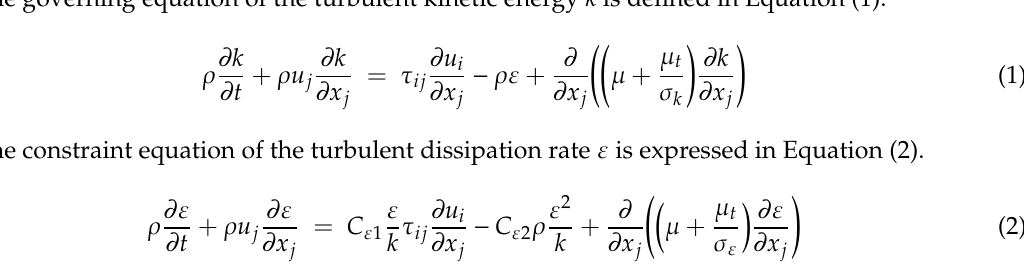
Figure 5. Mesh of the computational domain.